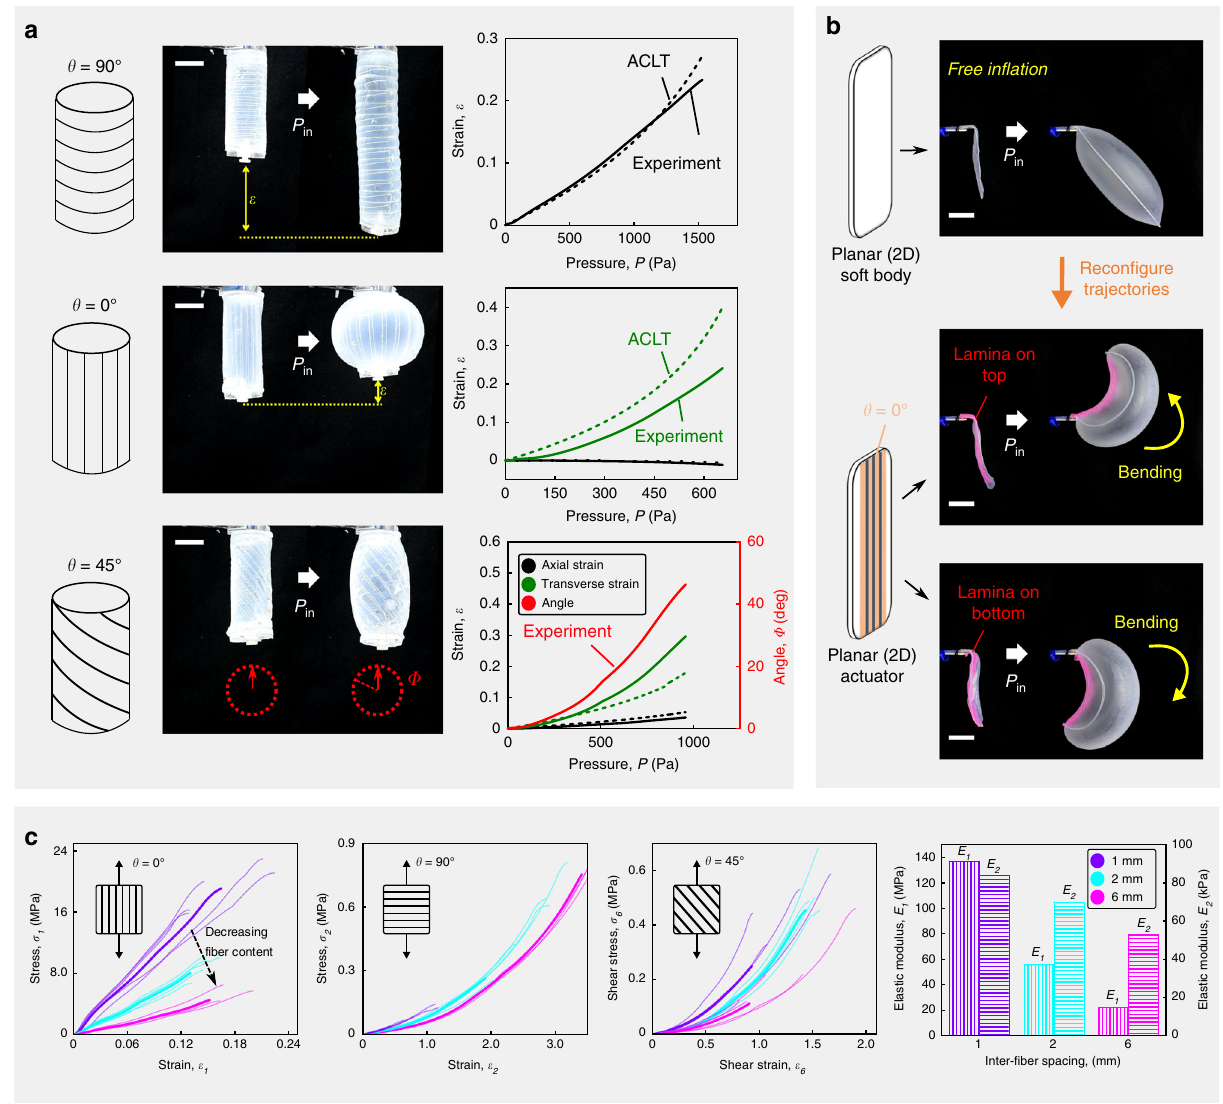
Fig. 2 Basic programmed in fl ation trajectory of 2D/3D soft bodies and mechanical characterization of STAUD-prepreg. a In fl ating cylindrical actuator wrapped with one STAUD-prepreg lamina at different fi ber orientations of θ = 90°, 0° and 45°. Experimental results are juxtaposed with analytical results from augmented classical laminate theory (ACLT). Legend color codes apply to all plots. Scale bar: 25 mm. b Planar soft body consisting of two silicone rubber fi lms and recon fi guration of its in fl ation trajectory by adhering one STAUD-prepreg. Scale bar: 25 mm. c Quasi-static uniaxial tensile testing results for STAUD-prepreg. E 1 and E 2 denote the Young ’ s modulus of the STAUD-prepreg along the fi bers ( θ = 0°) and perpendicular to the fi bers ( θ = 90°), respectively. Higher fi ber content in the prepreg results in lager values of E 1 and E 2 . E 1 is ~1000-times greater than E